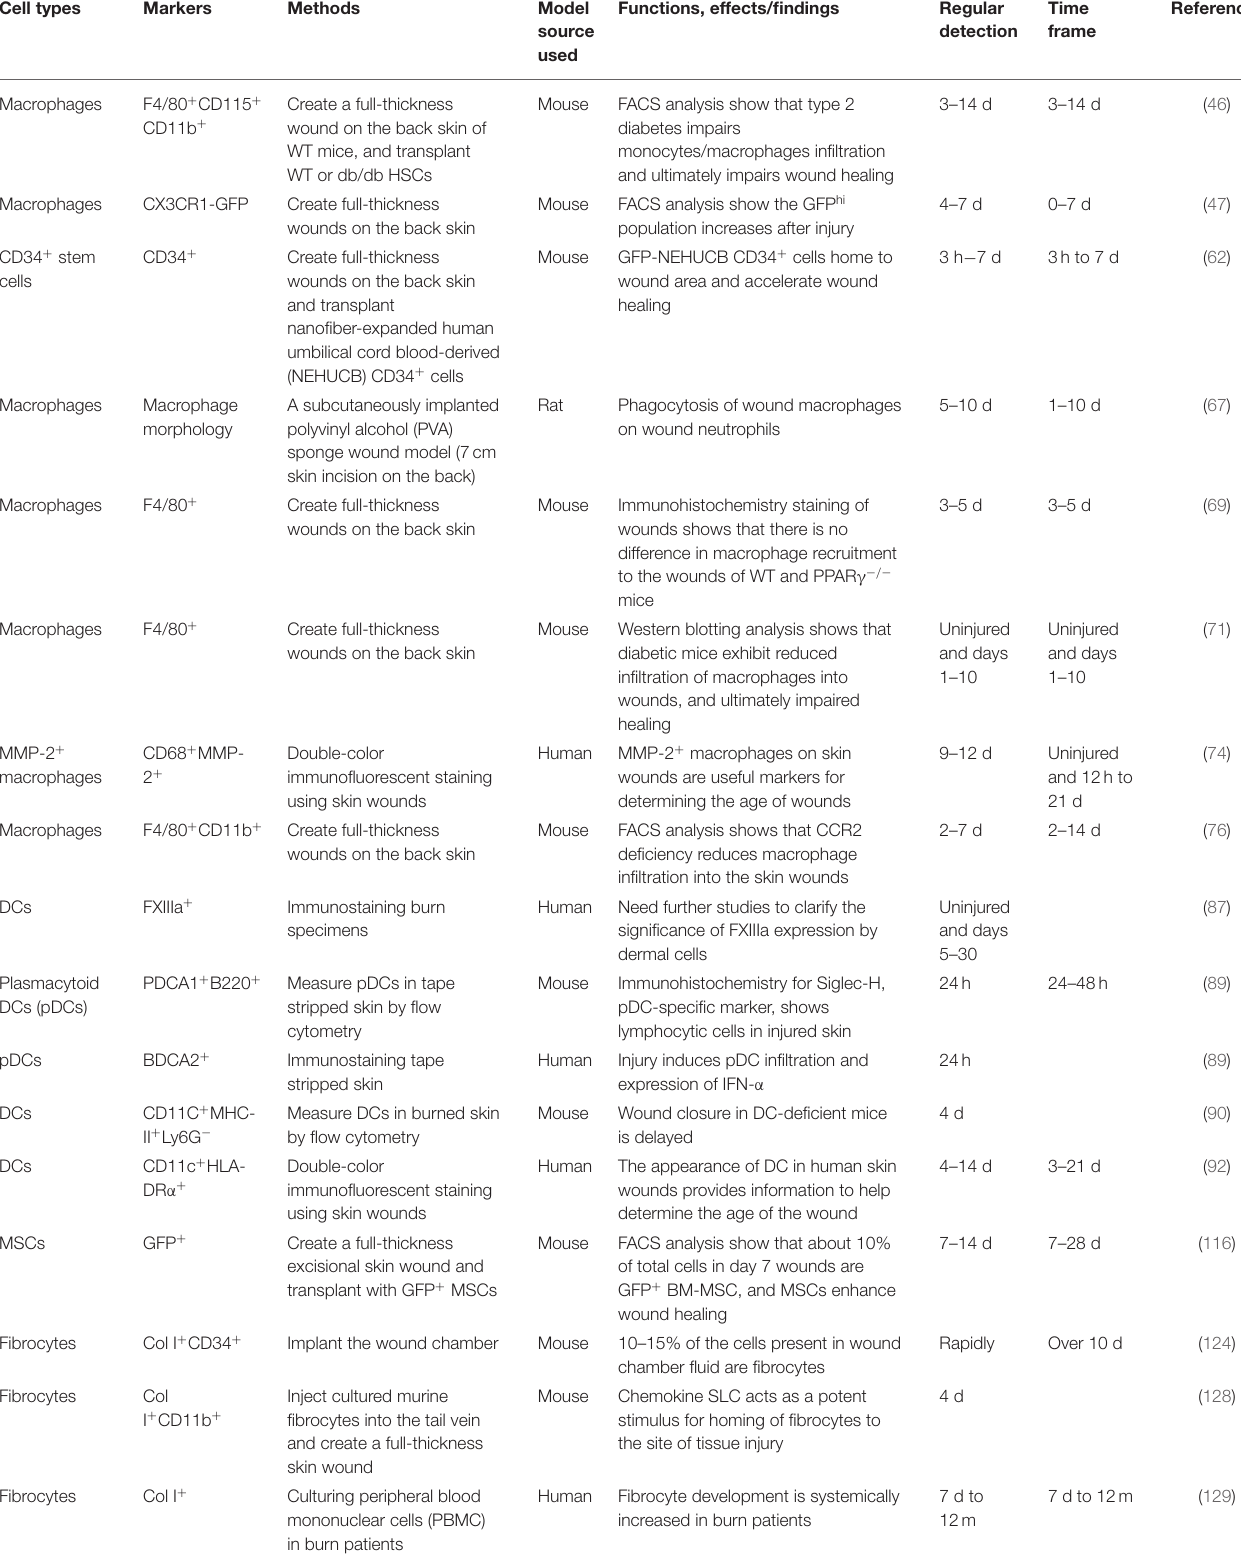
TABLE 2 | Summary of related studies on the appearance and effects of BMDCs on the skin wound healing process. Cell